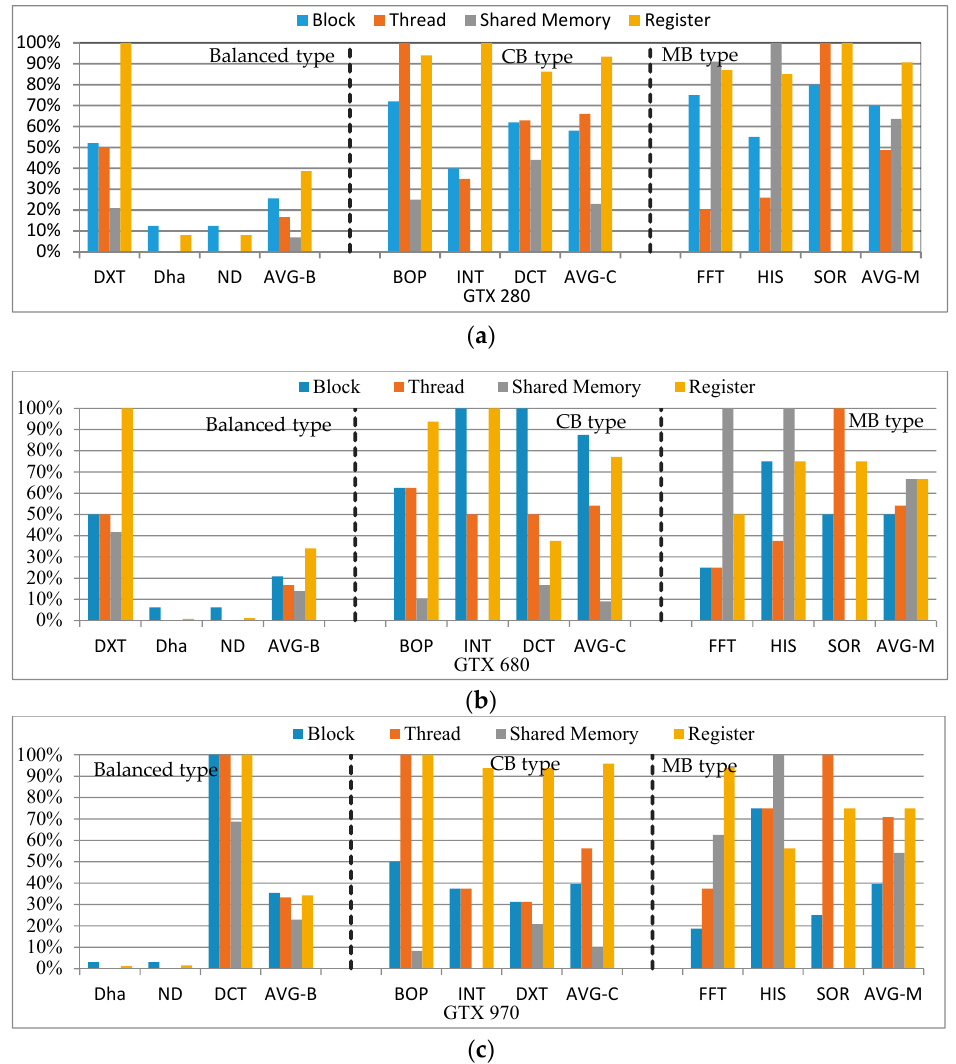
Figure 9. The resource utilization of different type kernels on different GPUs. ( a ) Resource utilization on GTX 280; ( b ) Resource utilization on GTX 680; ( c ) Resource utilization on GTX 970.